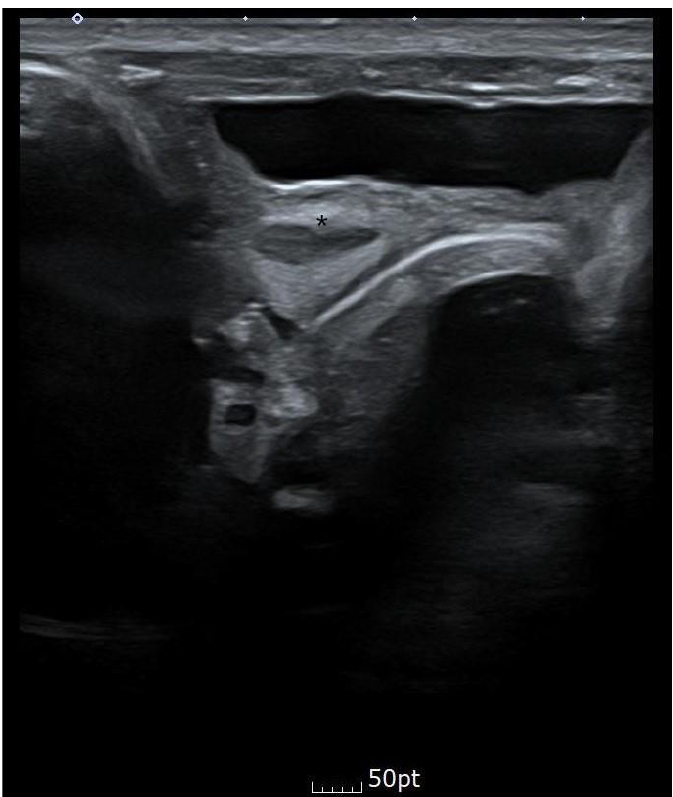
Figure 4. When an abdominal ultrasound transverse section performed with a linear probe was performed, a bicornuate or septate uterus was suspected. Fundus level of the uterus, * a projection in the middle of the uterus. the middle of the